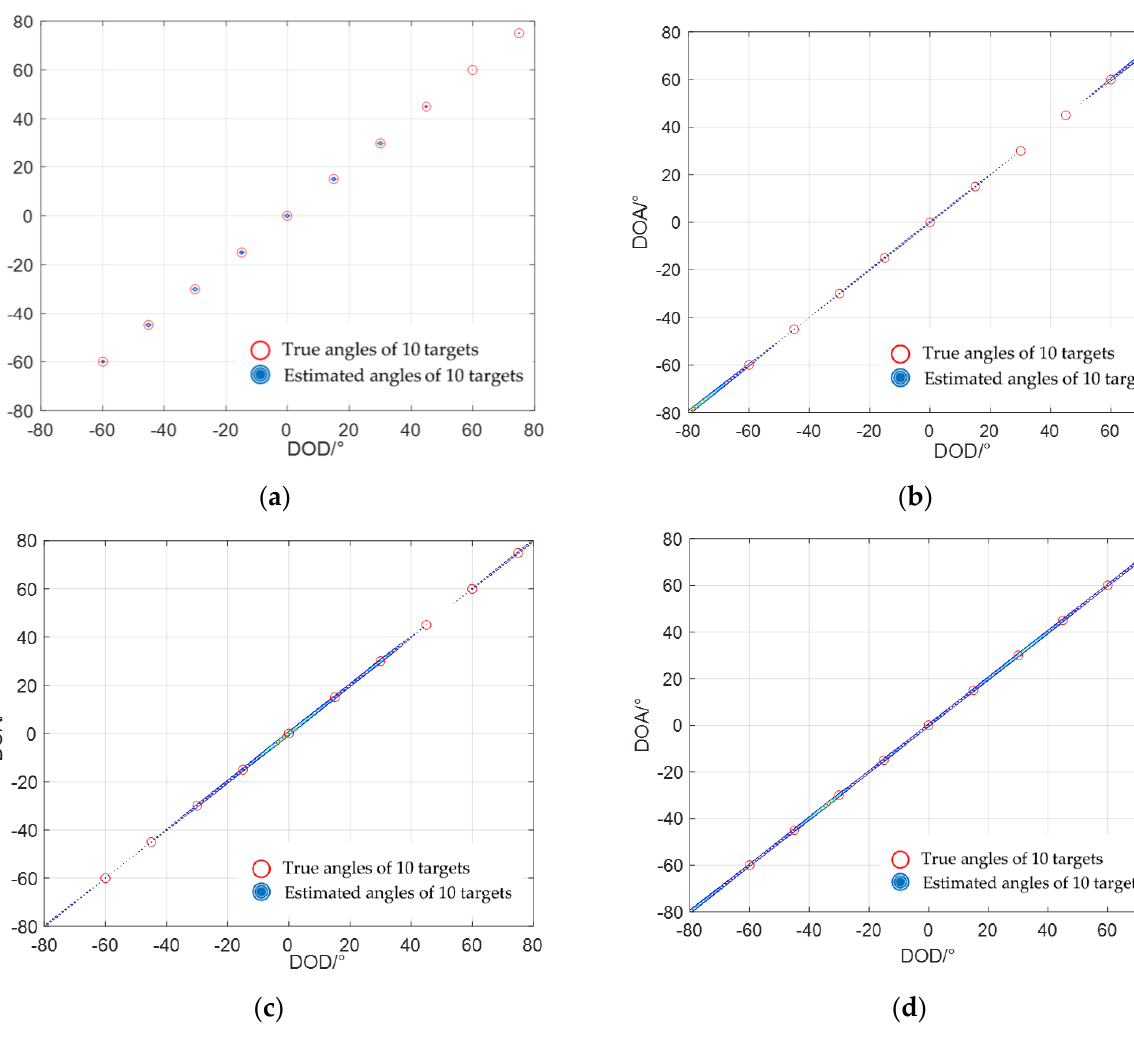
Figure 3. Results of estimating 10 targets by different algorithms: ( a ) LMR algorithm; ( b ) SMS algorithm; ( c ) ASDS algorithm; ( d ) TRDS algorithm.